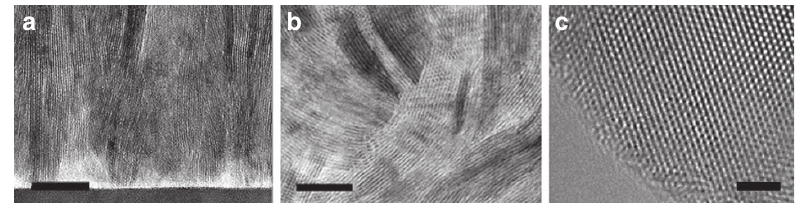
Figure 1 | TEM images of MoS 2 bulk crystals and thin films. ( a ) Cross-sectional TEM image of the MoS 2 thin film with vertically aligned basal plane. Scale bar, 20nm. ( b ) Plan-view TEM image of the MoS 2 thin film. Scale bar, 10nm. ( c ) Plan-view TEM image of the bulk MoS 2 crystal. Scale bar,